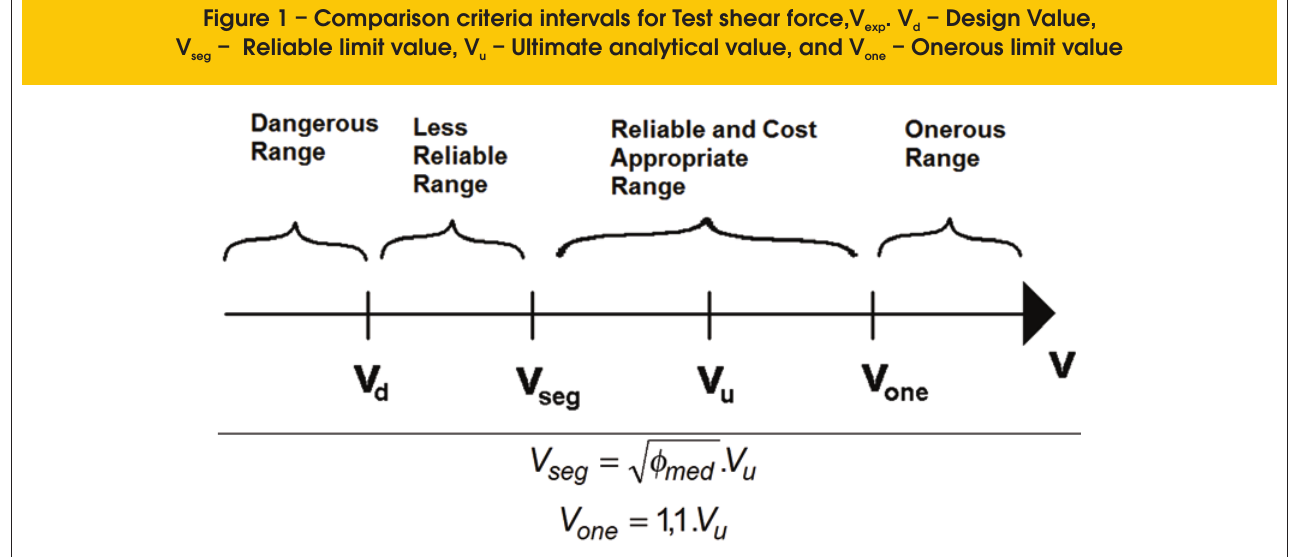
Figure 1 – Comparison criteria intervals for Test shear force,V . V – Design Value,